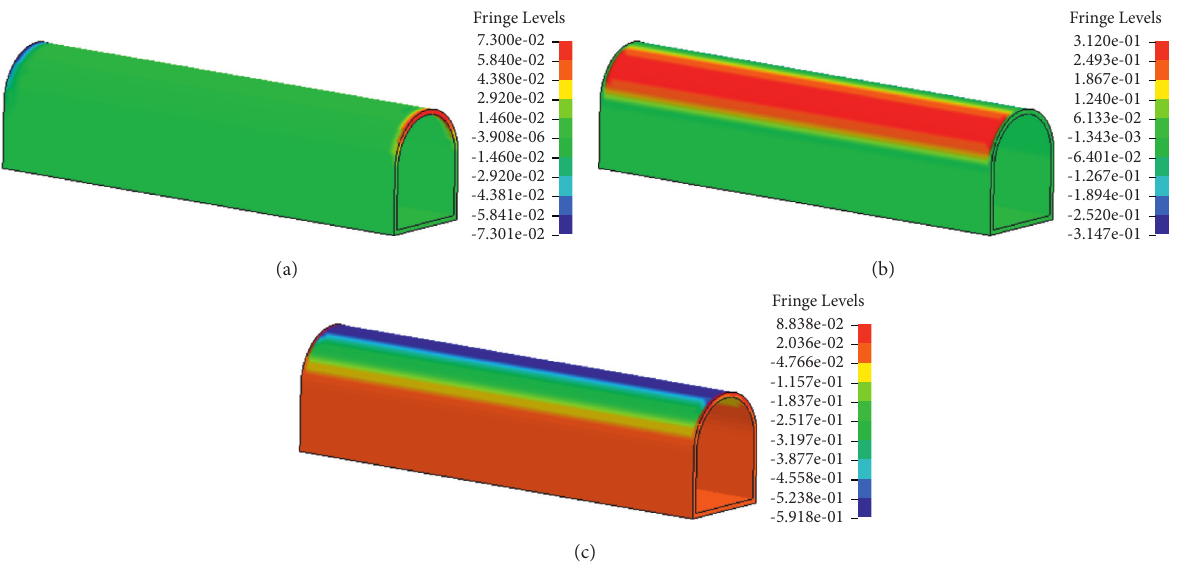
Figure 5: The displacement nephograms of the existing tunnel structure in condition 1.